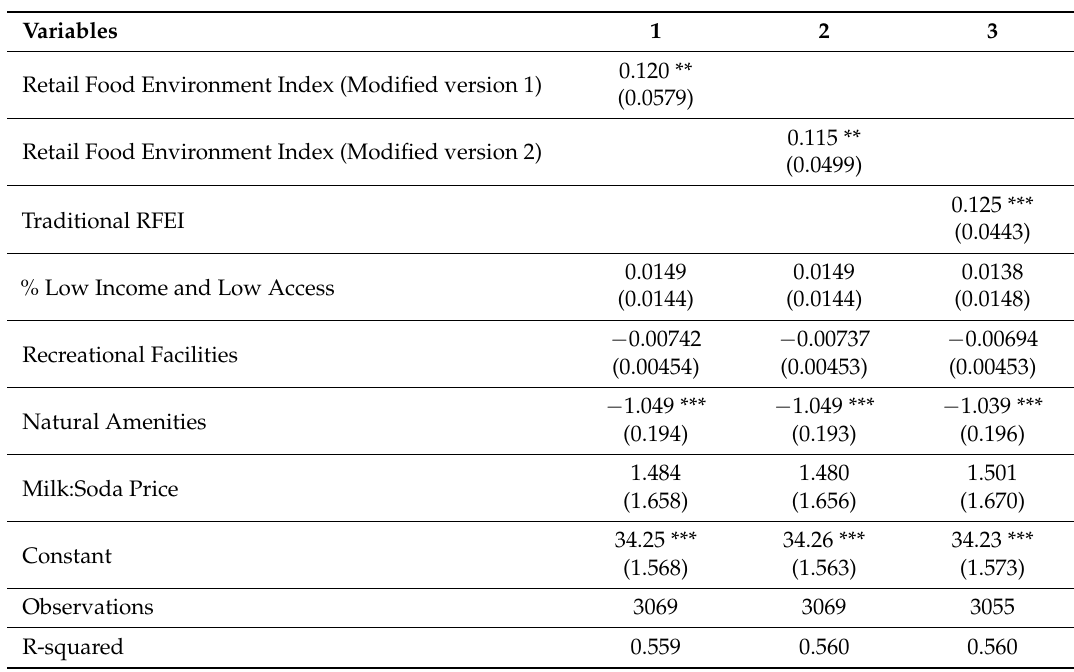
Table 6. OLS estimates of food swamps on obesity, controlling for food desert effect for all U.S. counties ( N = 3108) *.